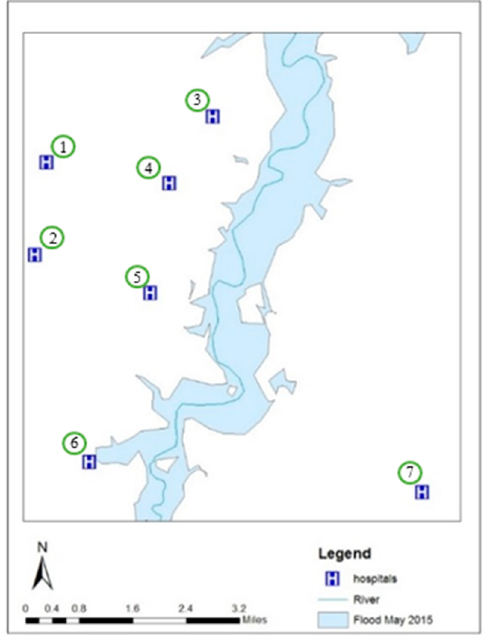
Figure 9. Location of hospitals in and around the inundated area due to Flood of May 2015.